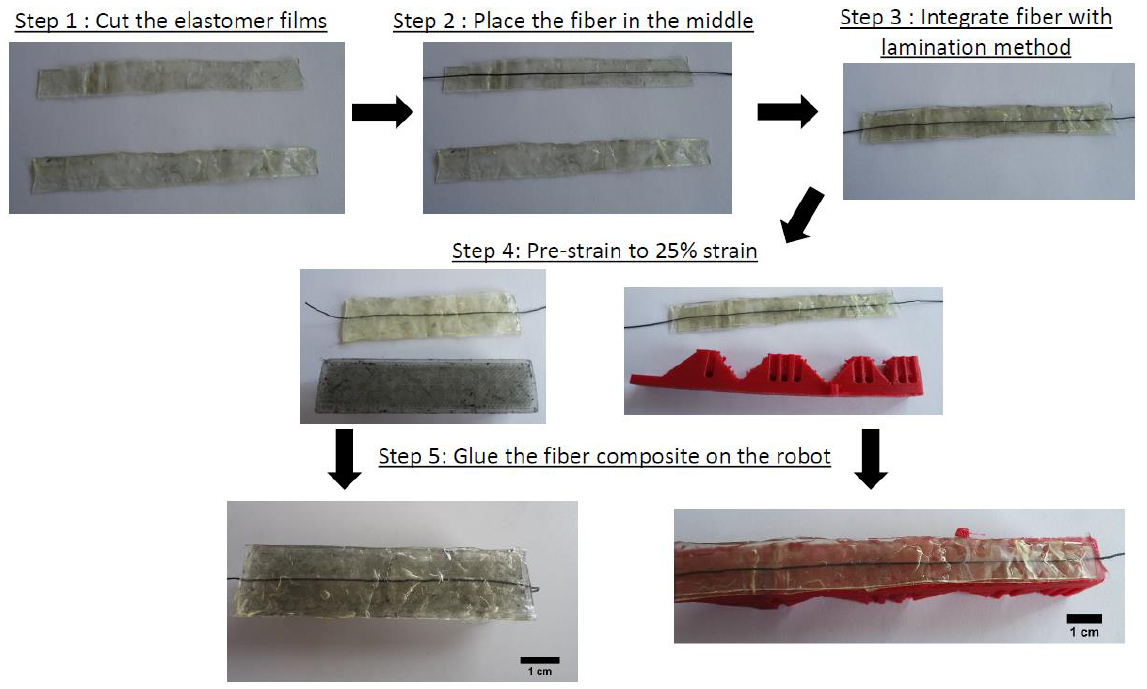
Figure 4. Schematic description of the ShSFC fabrication steps for the electronic skin and the attachment on the soft robot.